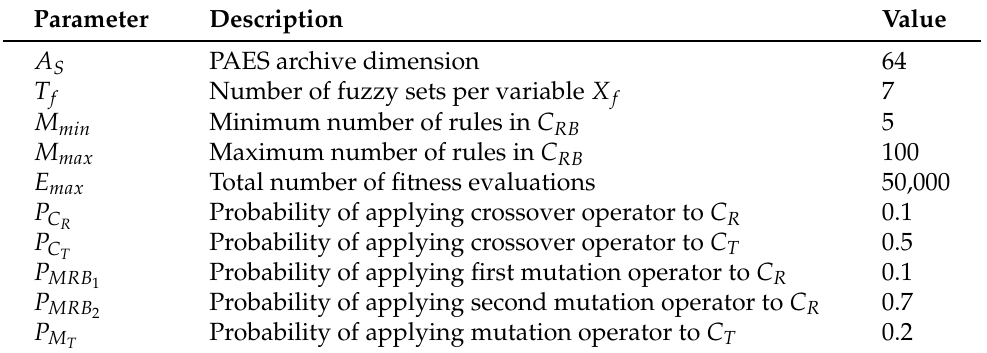
Table 12. Values of the parameters for PAES-RCS used in the experiments.